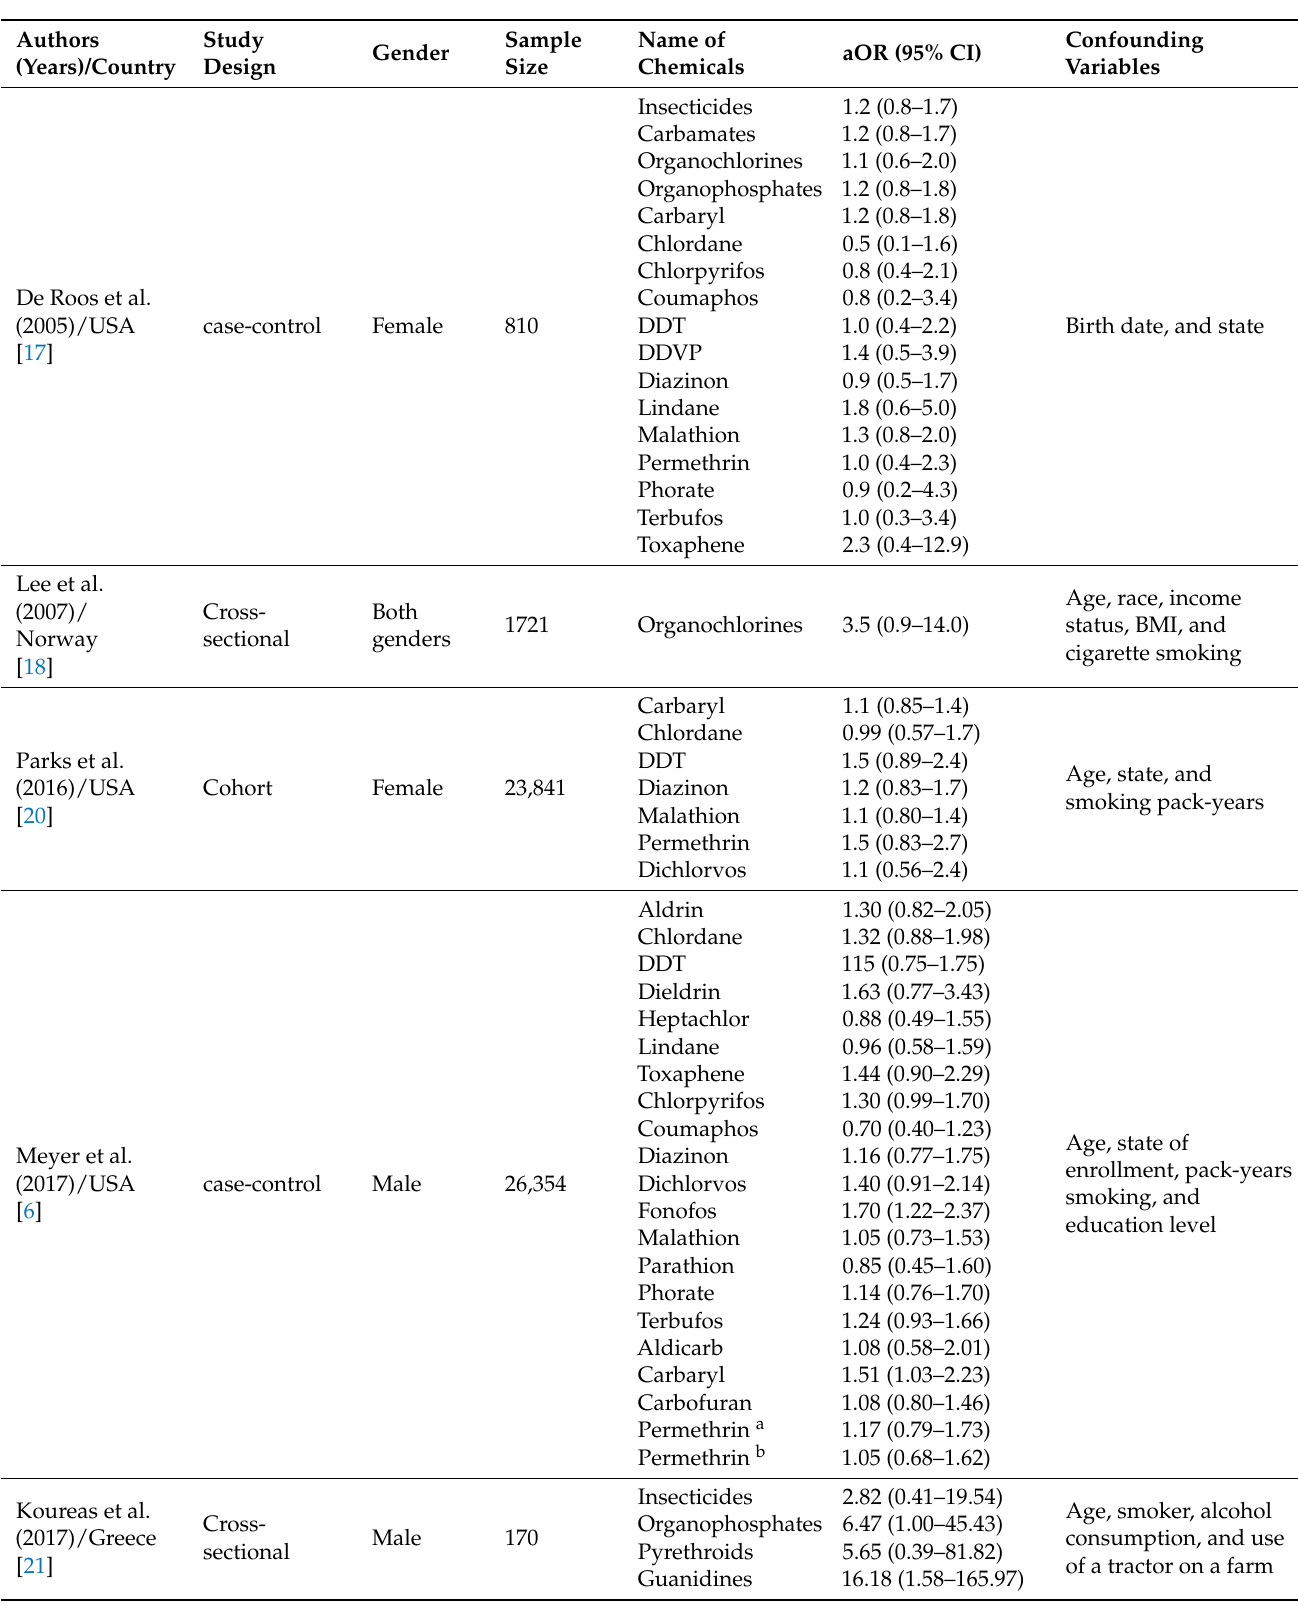
Table 1. The association between exposure to insecticides and RA